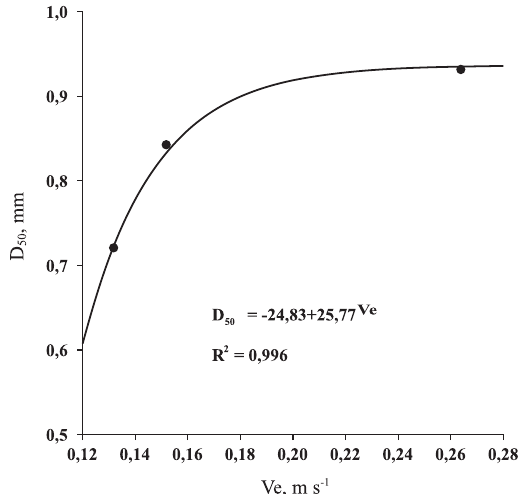
Figura 5. Relação entre o índice D e a velocidade da enxurrada, Ve, nos tratamentos durante o cultivo da soja, em um Nitossolo Háplico (média das repetições e dos testes de